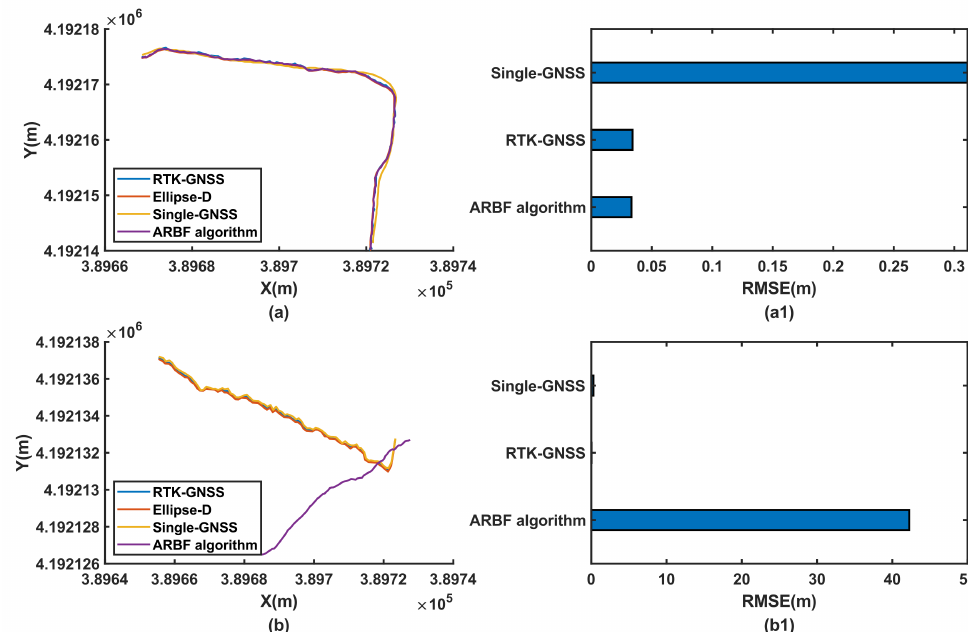
Figure 13. Position prediction results under sensor failure condition: ( a ) position prediction results of ARBF for RTK-GNSS and IMU case; ( a1 ) RMSE results for RTK-GNSS and IMU case; ( b ) position prediction results of ARBF for RTK-GNSS and encoder case; ( b1 ) RMSE results for RTK-GNSS and encoder